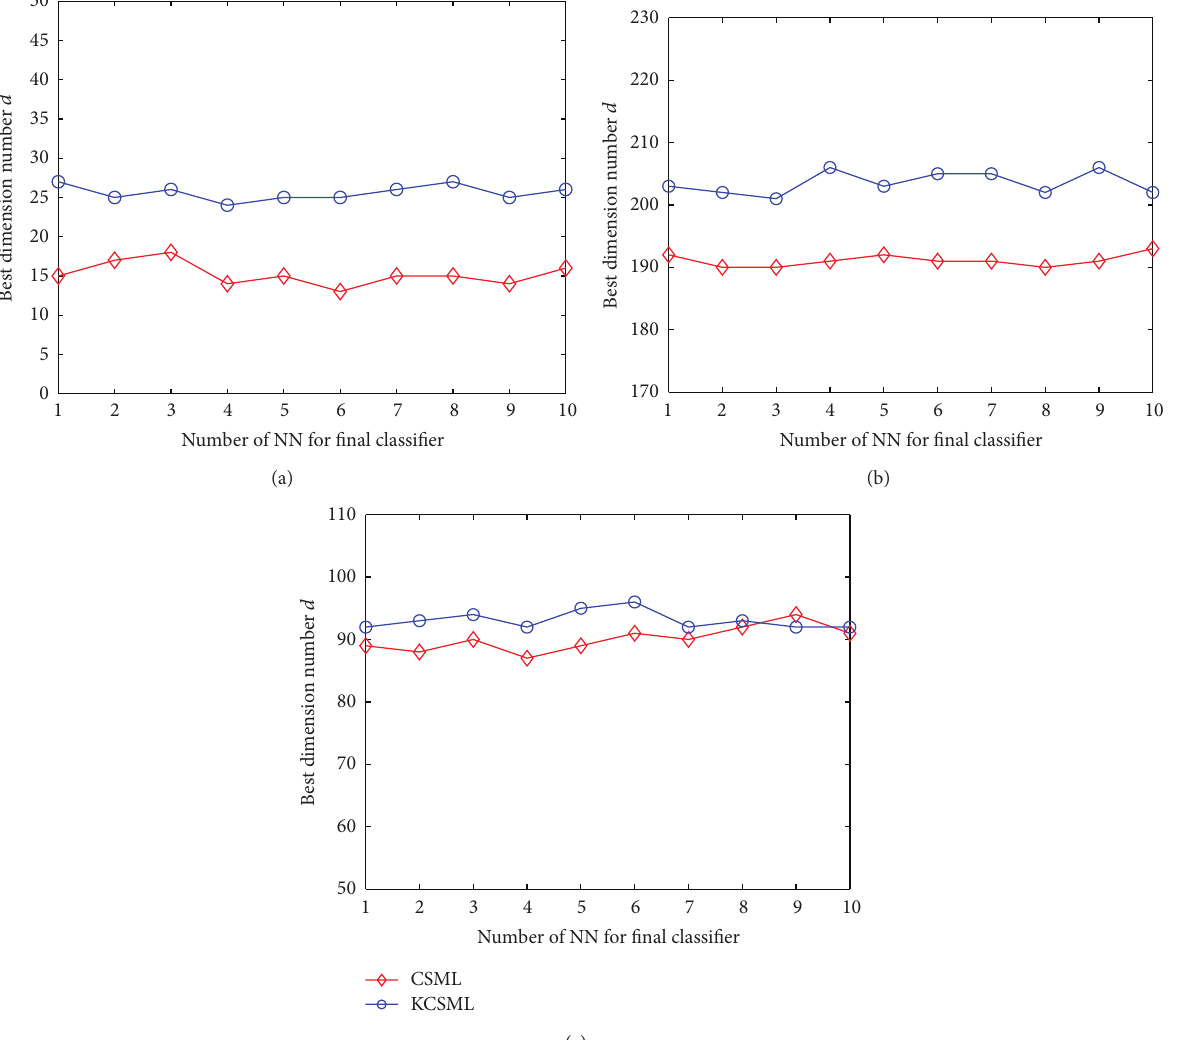
Figure 5: The best dimension number 𝑑 for various 𝑘 2 : (a) on Yale database, (b) on CMU PIE database, and (c) on MNIST